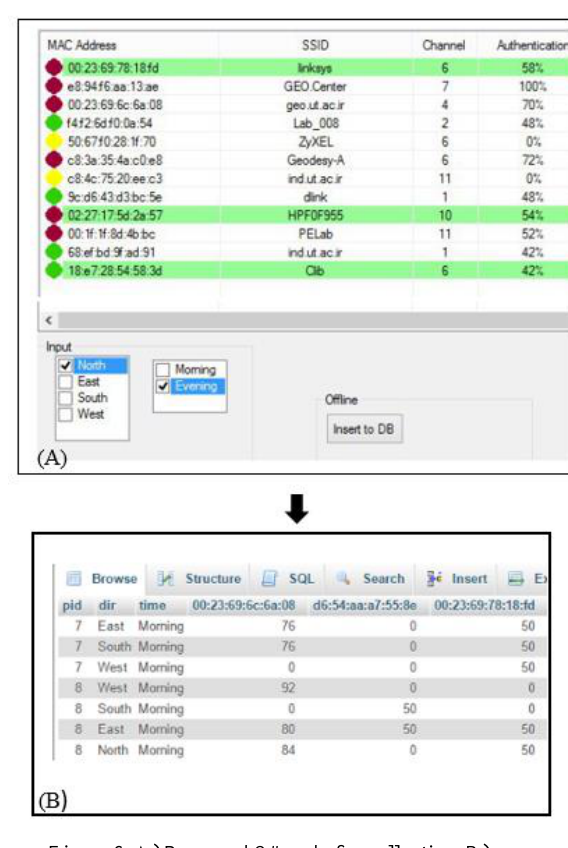
Figure 6. A) Proposed C# code for collecting, B) Insertion of RSS to MySQL database